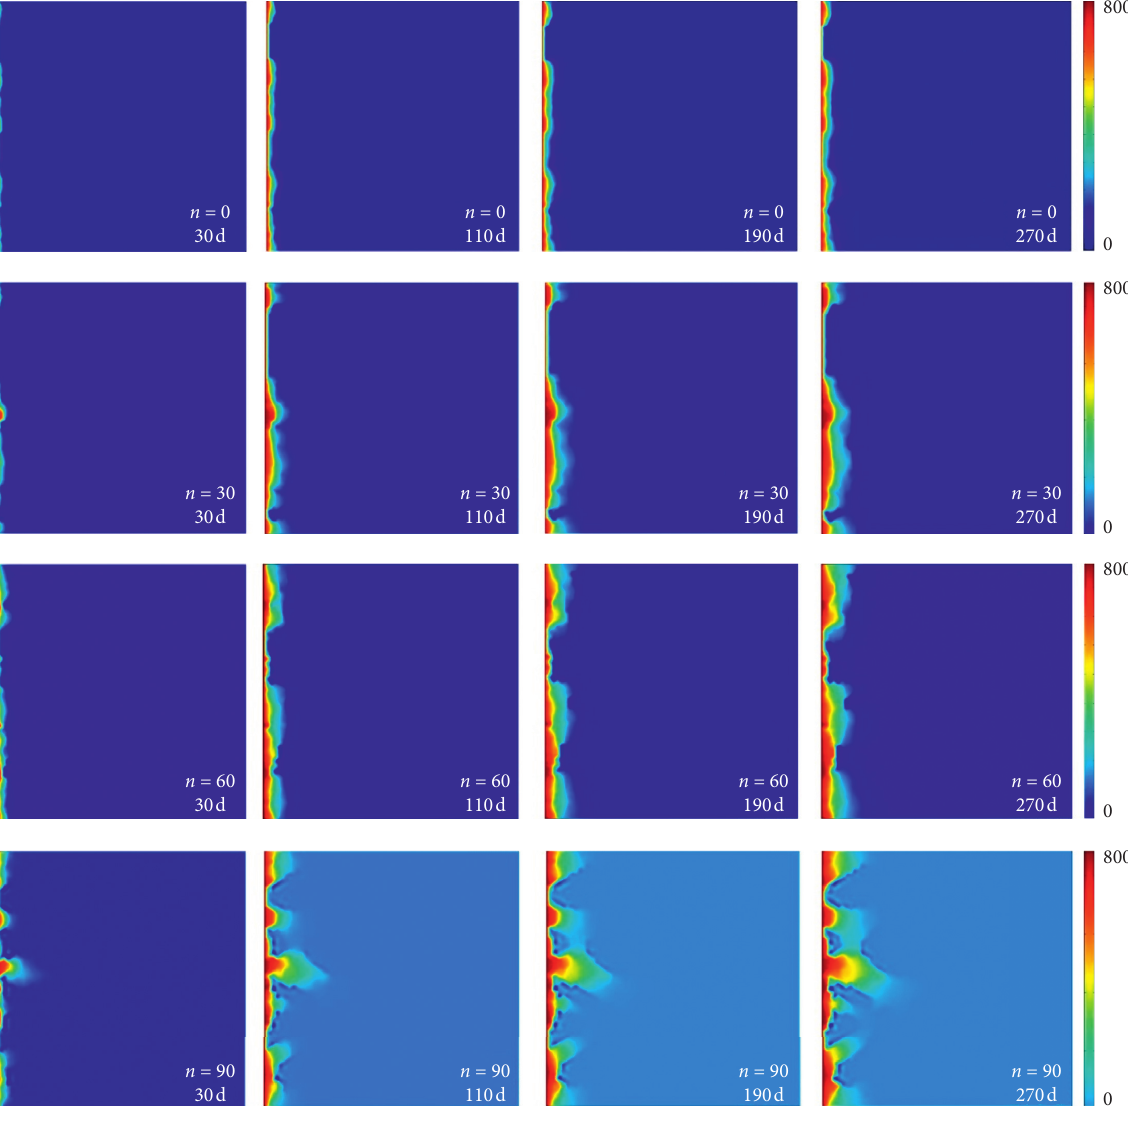
Figure 8: Cloud plots of chloride ion corrosion concentration distribution of concrete after